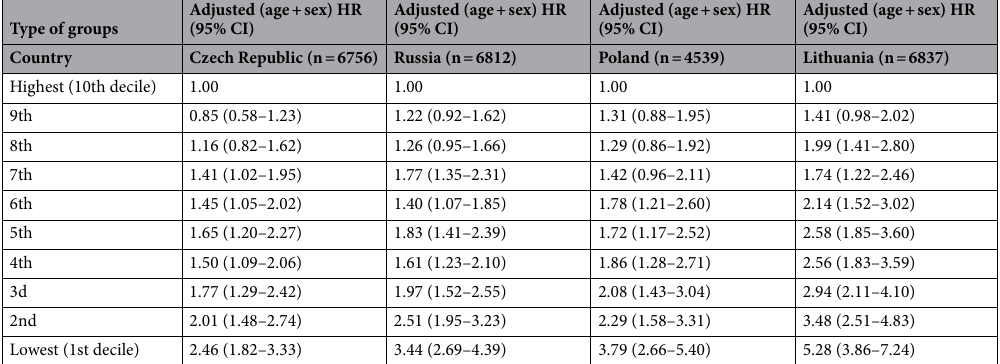
Table 4. Association between FEV1/height 3 deciles and all-cause mortality by country. FEV1 forced expiratory volume in 1 s, CI confidence interval, HR hazard ratio.